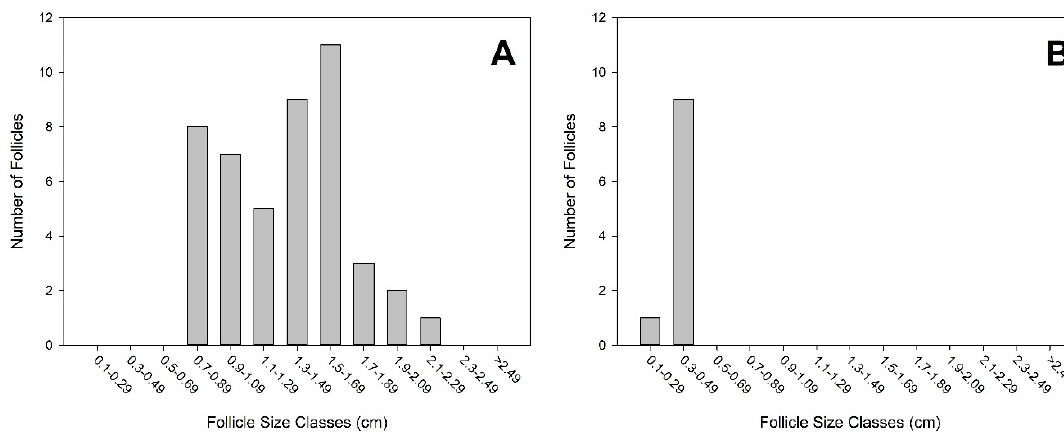
Figure 2. Numbers of ovarian follicles measured in two individual female Kemp’s ridley sea turtles, Lepidochelys kempii , found stranded in Texas, USA, in 1997. ( A ) Ovarian follicle measurements from an adult. ( B ) Ovarian follicle measurements from a juvenile.